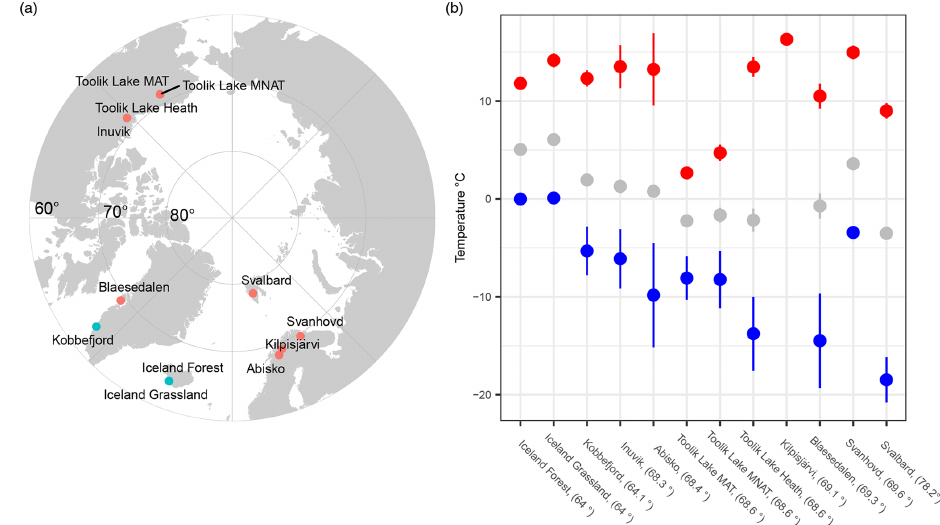
Figure 1. (a) Map, with the polar projection, showing the 12 sampling sites across the Arctic and (b) the average values of soil thermal regimes for each site, including the maximum (red), mean (gray), and minimum (blue) soil temperature. Error bars indicate the standard deviation across the